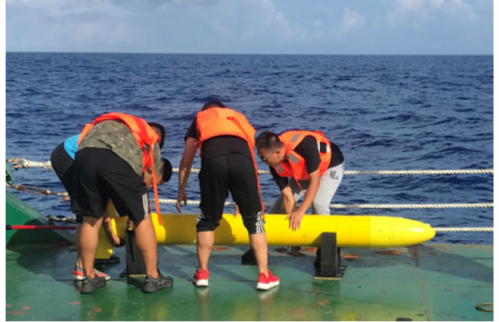
Figure 1. Petrel-L glider in South China Sea.